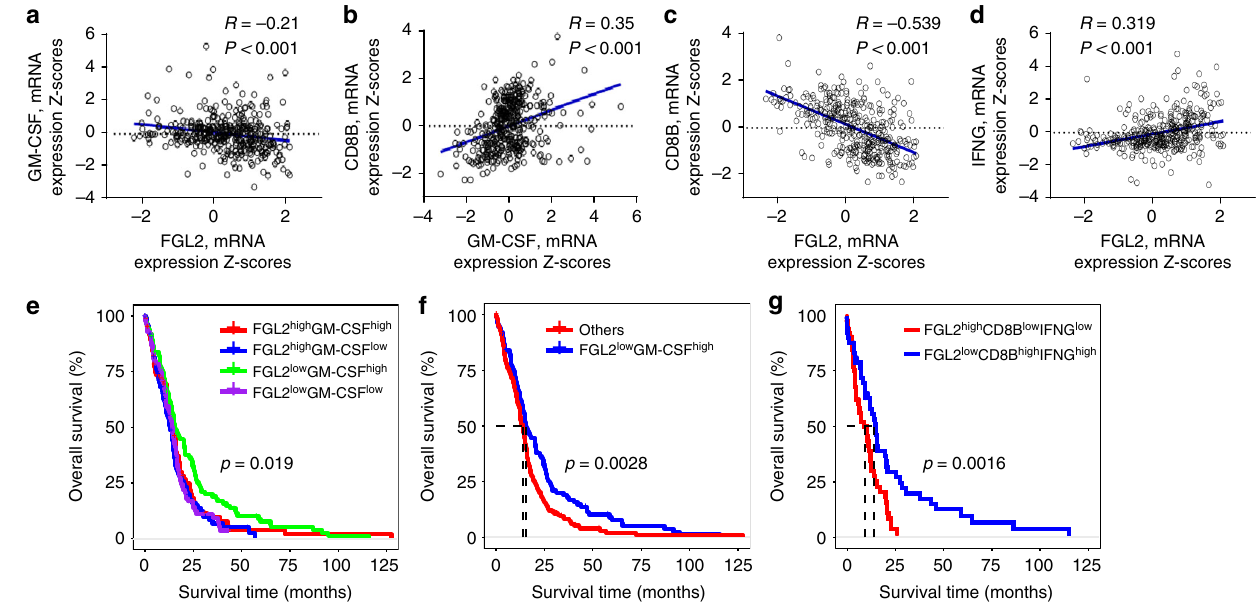
Fig. 7 Expression level of FGL2 and GM-CSF predicts outcome in GBM patients. Data on survival of GBM patients and gene mRNA expression data ( n = 401 patients) were downloaded and retrieved from the TCGA data portal ([http://www.cbioportal.org/public-portal/] Accessed between January 1, 2018, and March 15, 2018). The expression levels for both genes were categorized as high or low using median values as the cutoffs. a – d Correlations analysis of mRNA expression levels among FGL2 , GM-CSF , CD8B , and IFNG in GBM tumors analyzed using the Pearson correlation coef fi cient. R = Pearson correlation coef fi cient. e Kaplan – Meier survival analysis for OS of GBM patients in the TCGA dataset grouped by expression levels of FGL2 and GM-CSF mRNA. Patients ’ tumors were classi fi ed as FGL2 high GM-CSF low , FGL2 high GM-CSF high , FGL2 low GM-CSF low , or FGL2 low GM-CSF high . The log-rank test was used to compare overall survival among groups. f Kaplan – Meier survival analysis for OS of GBM patients in the FGL2 low GM-CSF high group vs. all others. The log- rank test was used to compare overall survival between groups. g Kaplan – Meier survival analysis for OS of GBM patients in the FGL2 low CD8B high IFNG high group vs. those in the FGL2 high CD8B low IFNG low group. The log-rank test was used to compare overall survival between groups. The statistical analyses